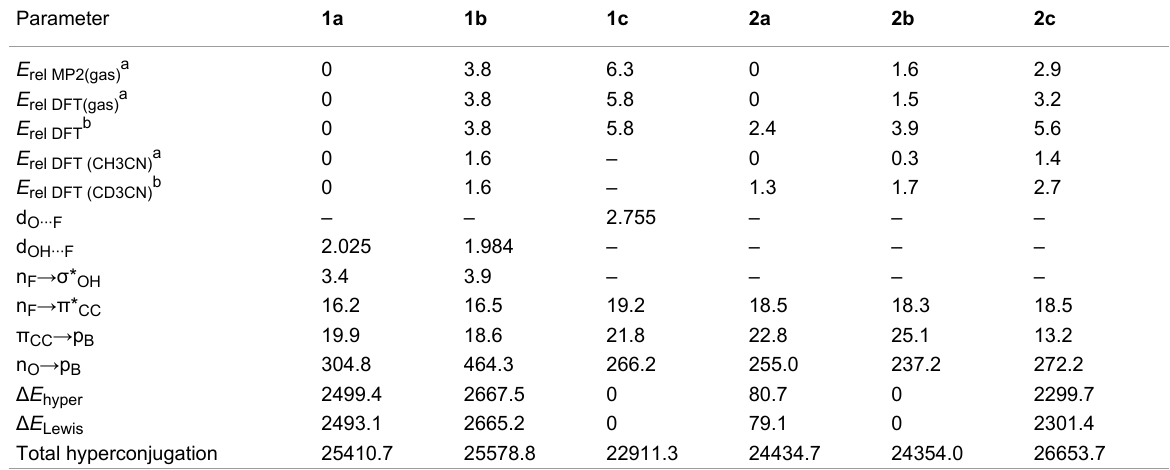
Table 1: Conformational energies (in kcal mol − 1 ), distances between interacting atoms by hydrogen bond and nonbonding interaction (in Å), and hyperconjugative/repulsive interactions (in kcal mol − 1 ). Parameter